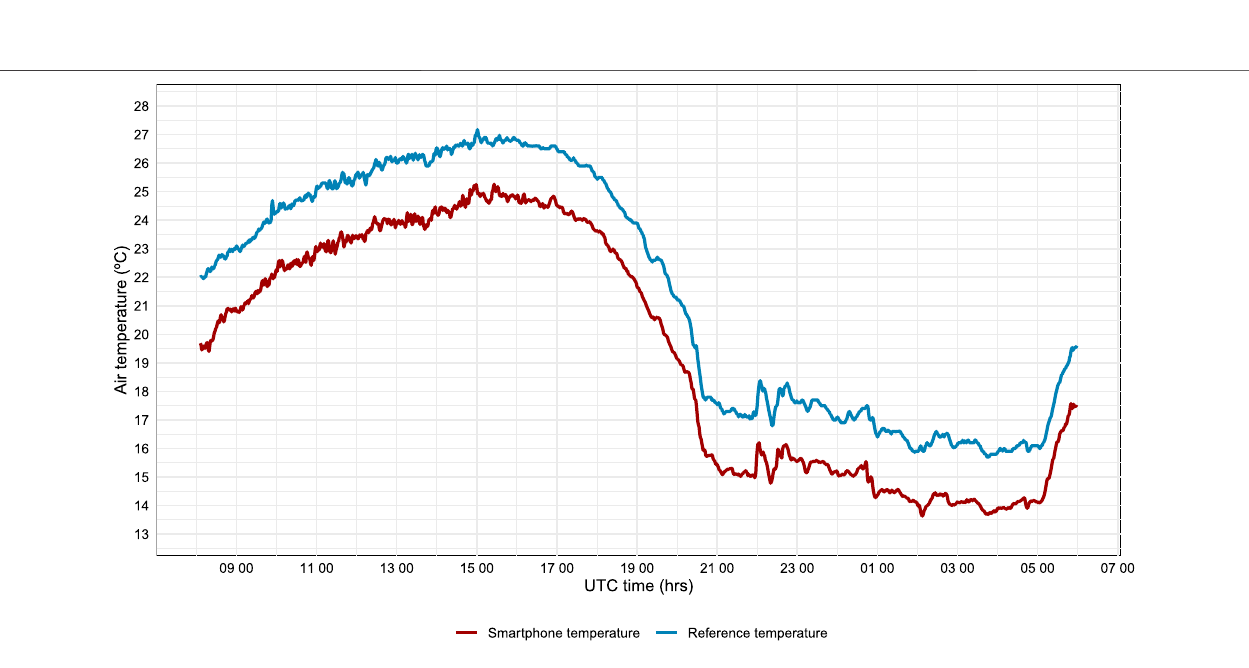
FIGURE4| TimeseriesofobservedairtemperaturefromthesmartphoneandreferenceweatherstationVeenkampenduringafollow-upexperimentinJune2021. During this experiment the smartphone is located inside the Stevenson screen. The experiment was executed from June 3 rd 2021 08:00 UTC till June 4 th 2021 06: 00